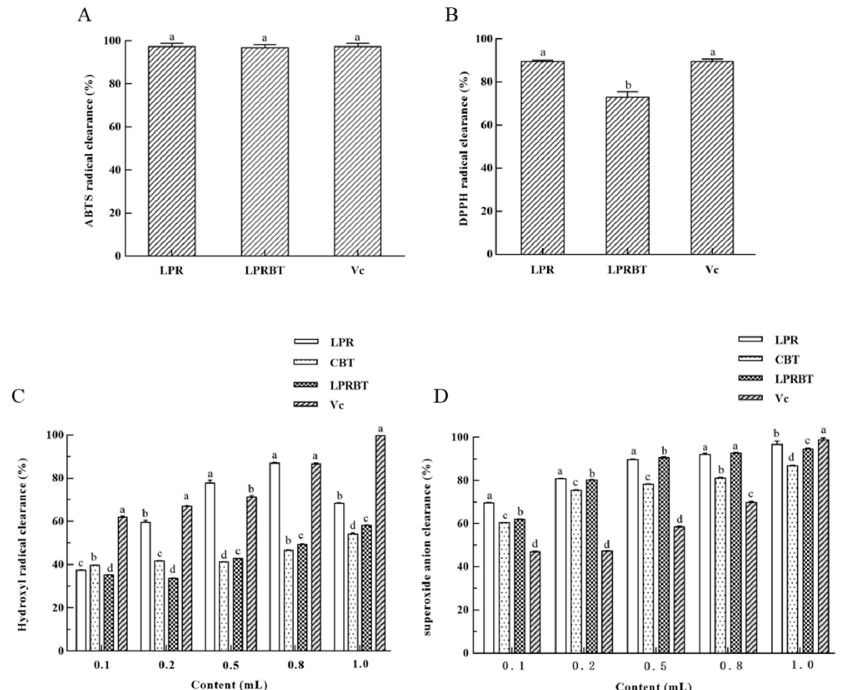
Figure 2. Anti-oxidation function of LPRBT, LPR, CBT, and Vc. ( A ) ABTS radical clearance activ- ity; ( B ) DPPH radical clearance activity; ( C ) Hydroxyl radical clearance activity; ( D ) Superoxide anion radical clearance activity. CBT: traditional black tea; LPRBT: L. polystachyus black tea; LPR: L. polystachyus ; Vc: vitamin C. Error bars indicate standard error (SE). Letter designations identify homogeneous groups. Different letters represent significant differences ( p < 0.05). The same letter means there are no statistically significant differences between the means ( p >